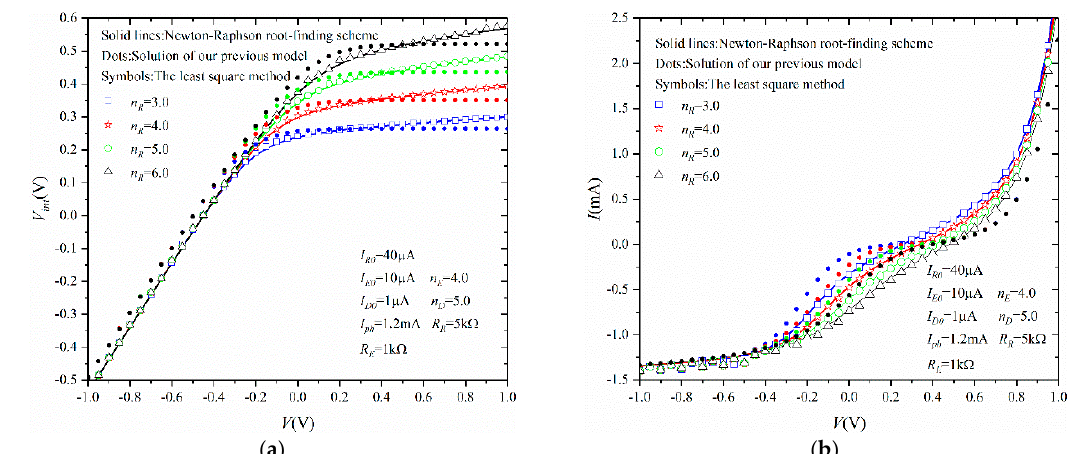
Figure 7. ( a ) V int ( V ) and ( b ) I ( V ) of the circuit in Figure 2 for different n R .